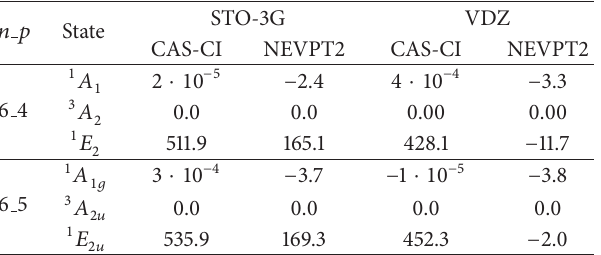
Table 6: Basis set effects for the nanotubes (6 4) and (6 5) . Table 7: Basis set effects for the nanotubes (7 4) and (7 5)